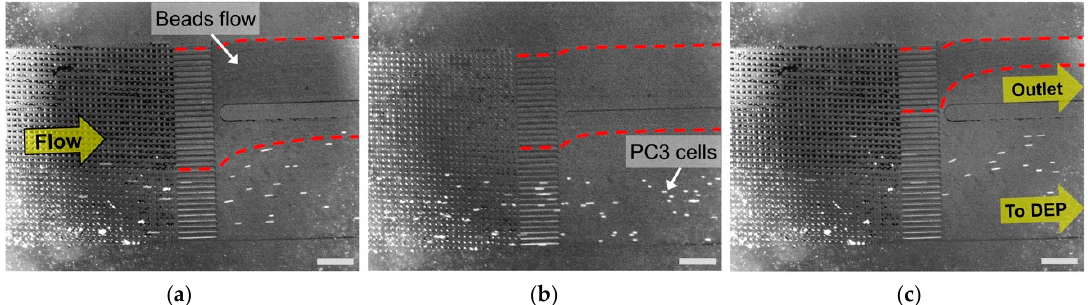
Figure 4. Microscopic images of cell purification in DLD module (scale bar: 500 µ m). Prostate cancer cells (PC3): stained with CellTrace ™ Calcein Red-Orange fluorescent dye (emission wavelength: 590 nm). Microbeads: Fluoresbrite ® YG carboxylate microspheres (emission wavelength: 486 nm).